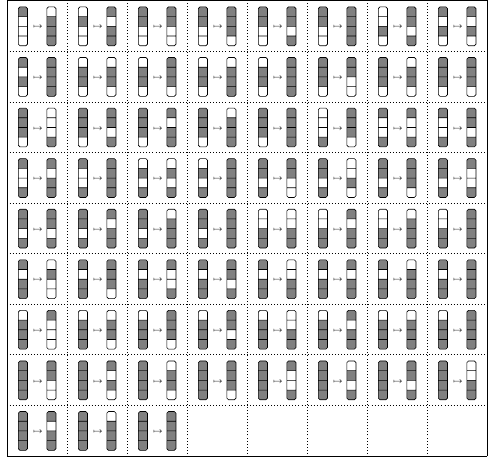
Figure 5: The Column-wise Active State Transitions for Class II Matrices Figure 3: Column-Wise Active State Transitions for M Used in QARMA -64